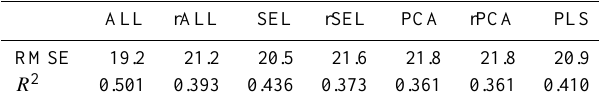
Fig. 7. Visualization of nowcasting (each plot shows 3 days).